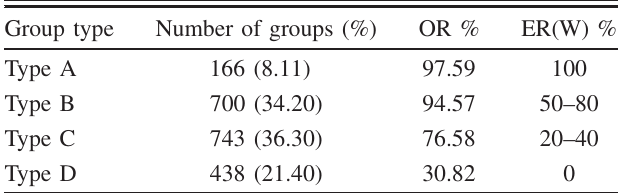
TABLE III. Group performance according to the number of individual-round correct answers in the group. OR: Observed rate of group performance. ER(W): Expected rate based on equal weight of individual